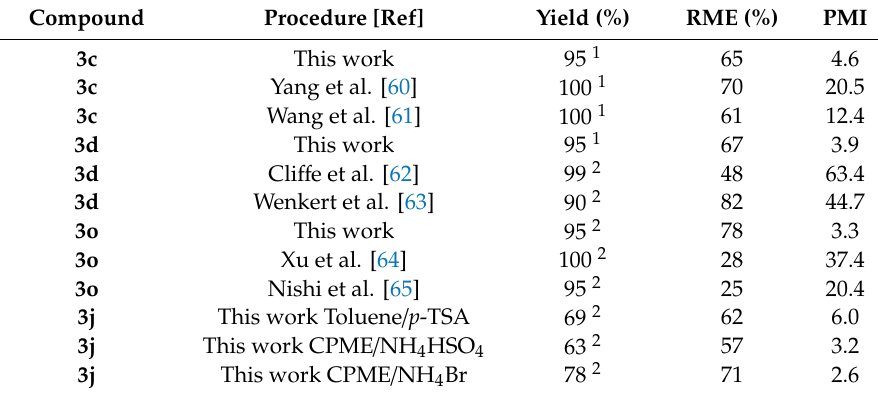
Table 5. Comparisons of green chemistry metrics for the synthesis of selected acetals. Compound Procedure